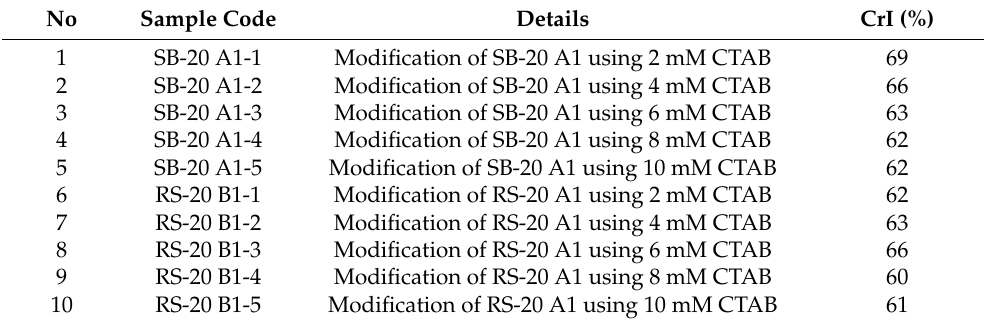
Table 2. Crystallinity of the modified CNC using CTAB from sugarcane bagasse (SB) and rice straw (RS).